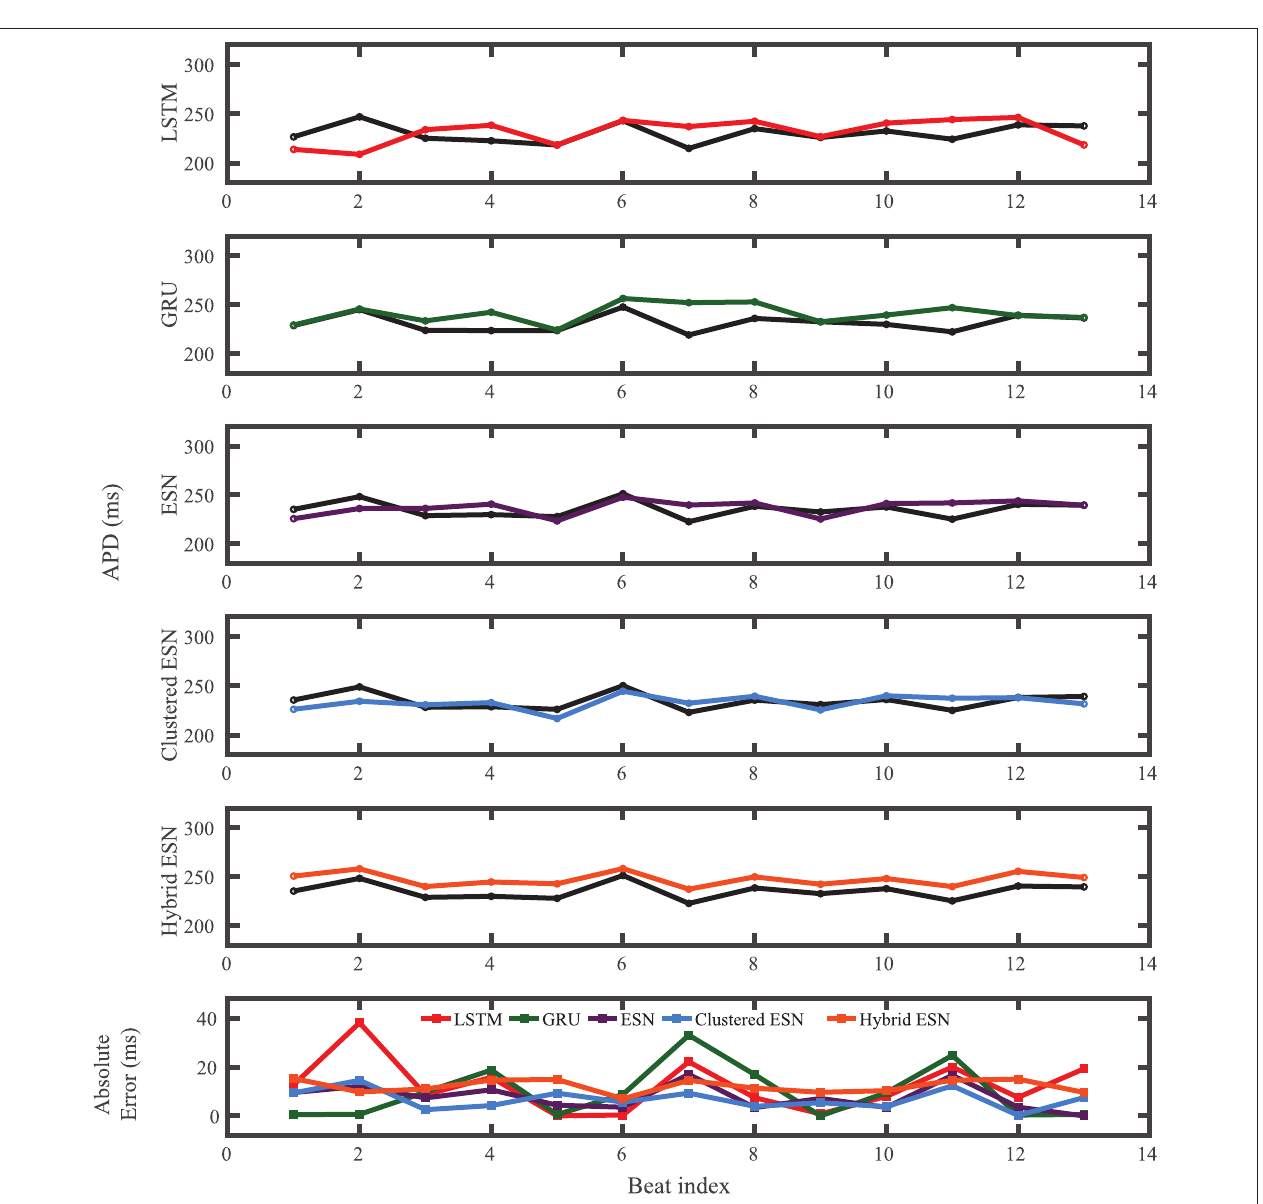
FIGURE 8 | Noble dataset APD prediction results obtained for the five methods using a fixed network size of 100 neurons. APDs from data used for testing are shown in black for reference and predicted APDs are shown in color. Absolute error in APD prediction is shown in the bottom subplot, with color corresponding to prediction